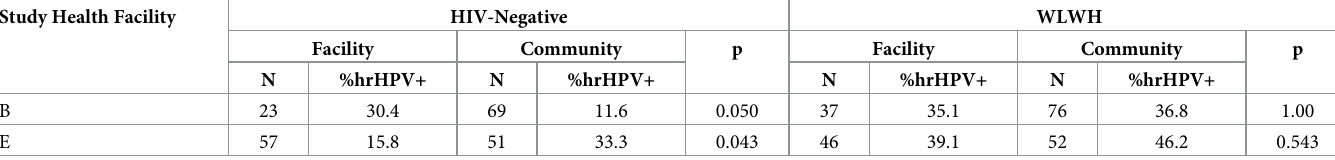
Table 3. Prevalence of high-risk human papillomavirus (hrHPV) by HIV status (HIV-negative women or women living with HIV (WLWH)) and recruitment strat- egy (facility or community). Study Health